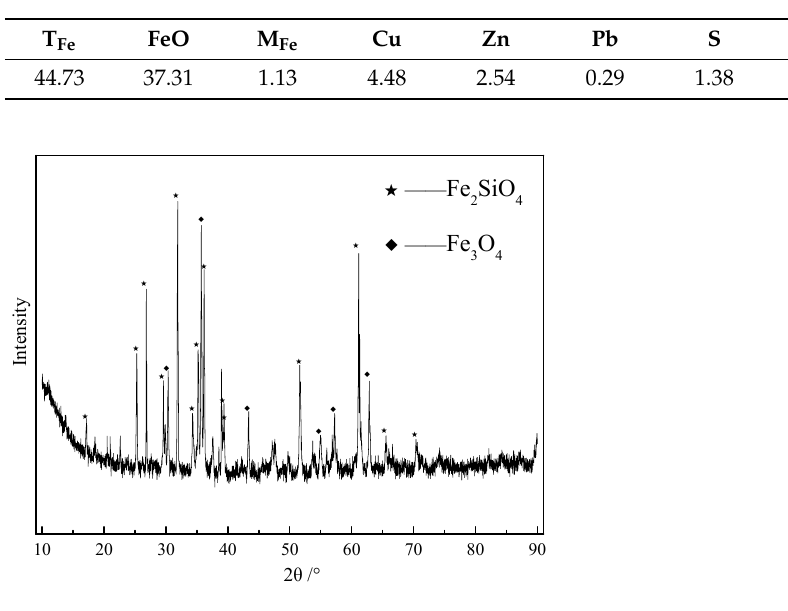
Figure 1. XRD analysis of copper slag.